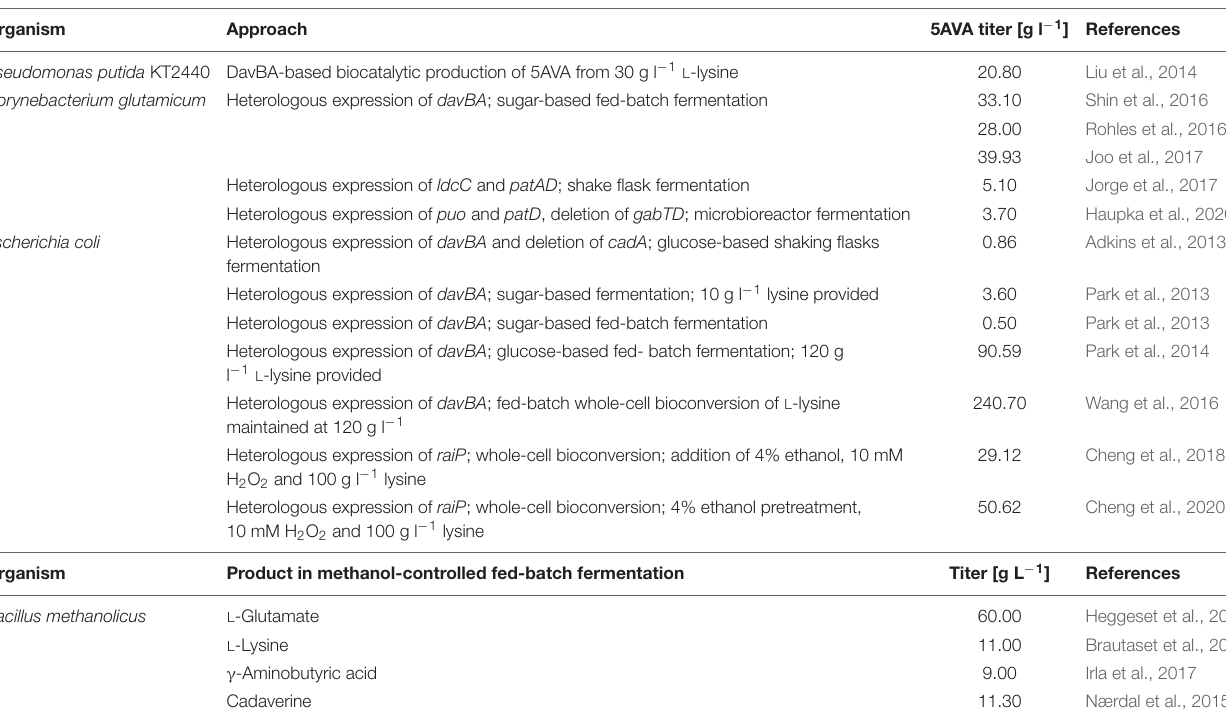
material for cloning of the 5AVA synthesis pathways: E. coli